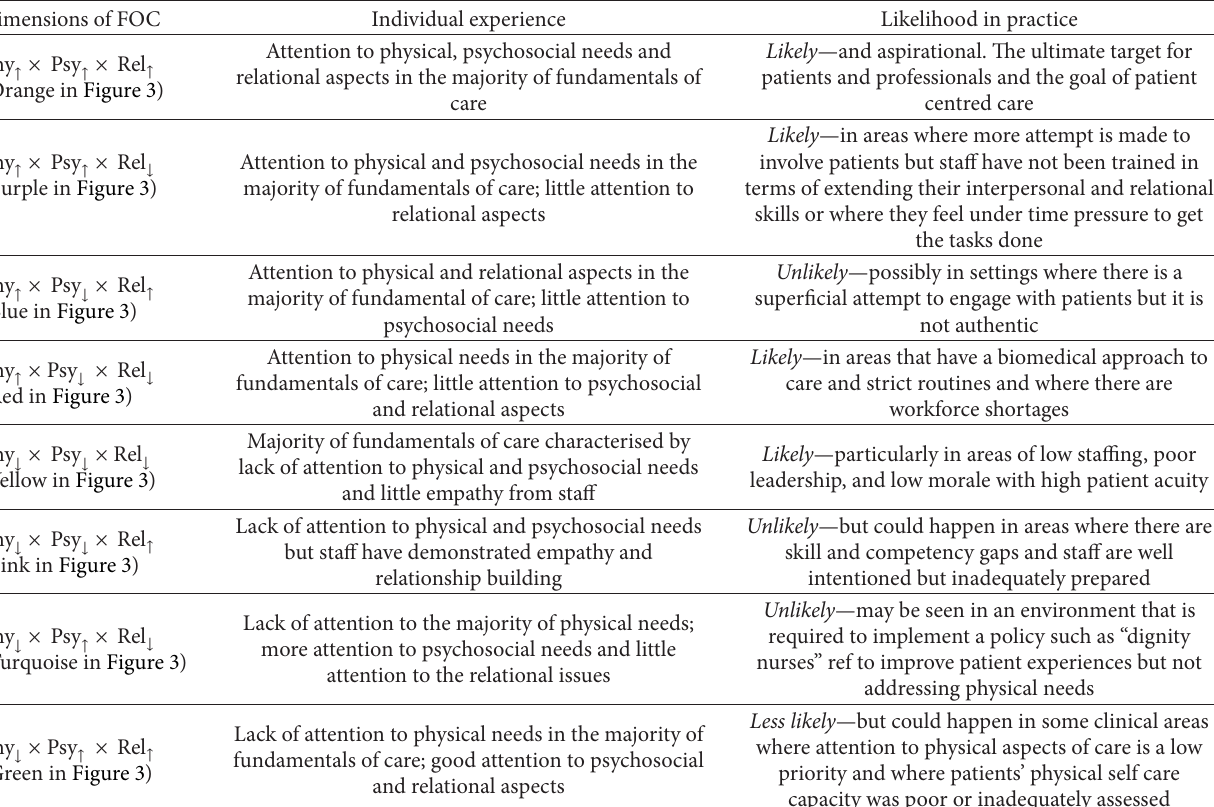
Table 2: Eight hypothetical dimensions of the fundamental of care